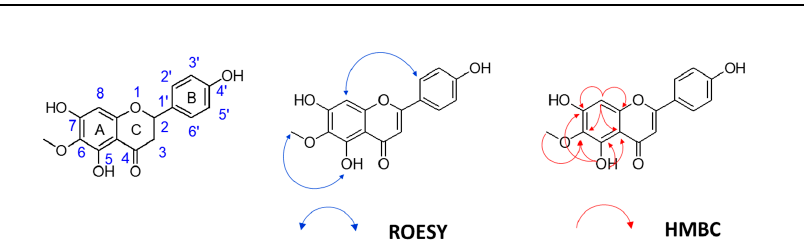
Figure 4. Key ROESY and HMBC correlations of hispidulin.